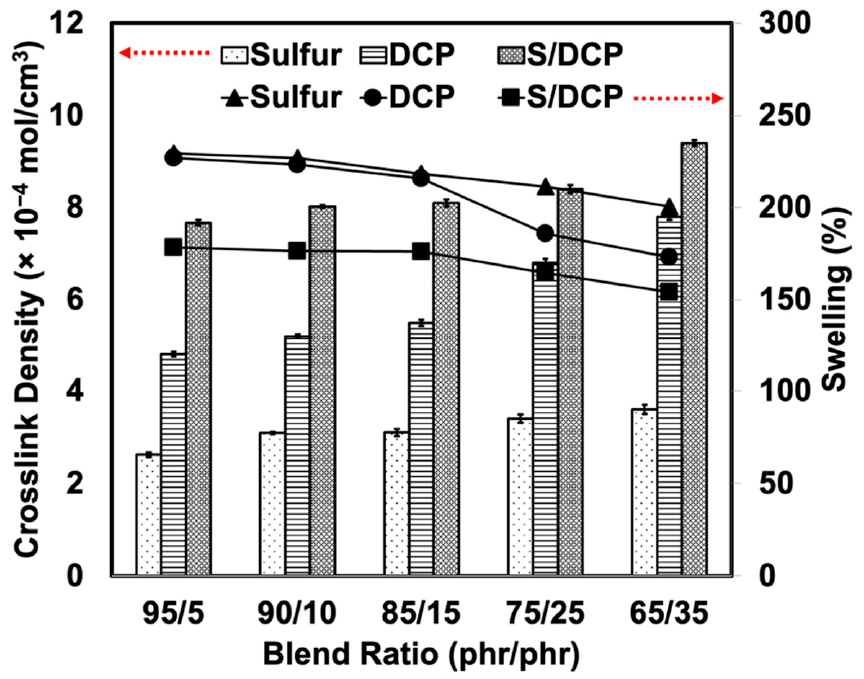
Figure 7. Swelling percentage and crosslink density of NR/r-NBR blends prepared with various crosslinking systems.